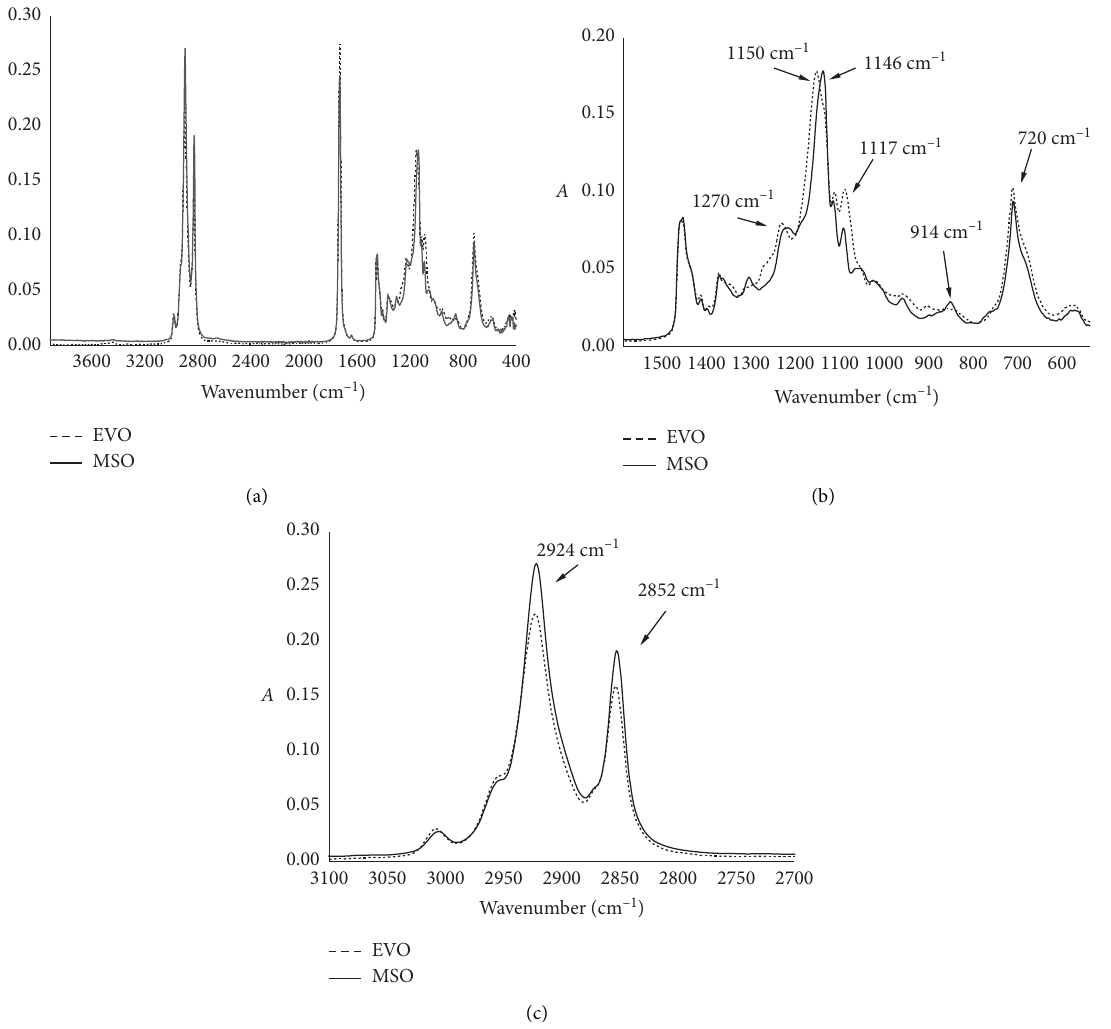
Figure 1: MIR spectra of EVO and MSO. (a) Full spectra 4000–400cm − 1 , (b) spectral range 1600–550cm − 1 , (c) spectral range 3100–2700cm − 1 [source: own